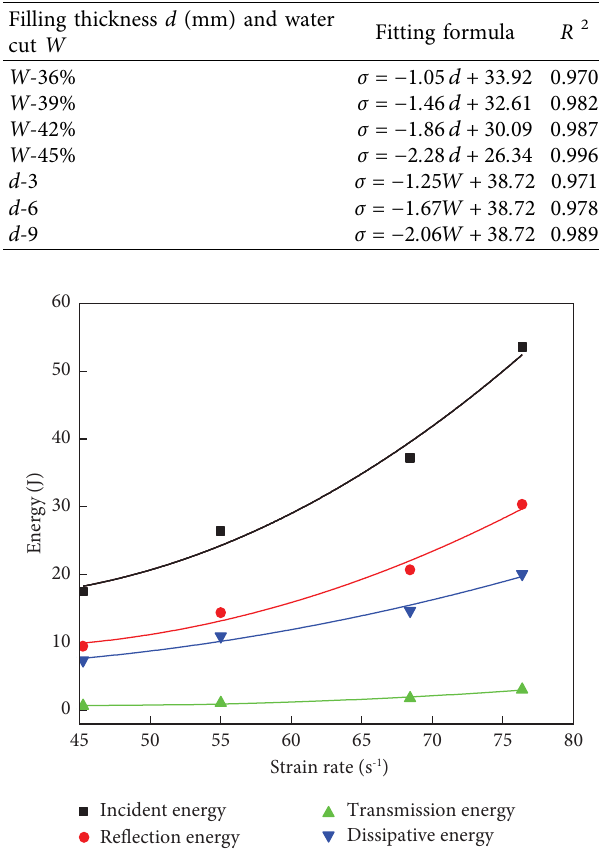
Figure 11: Stress-time history curve of composite specimens with diferent flling medium thicknesses.